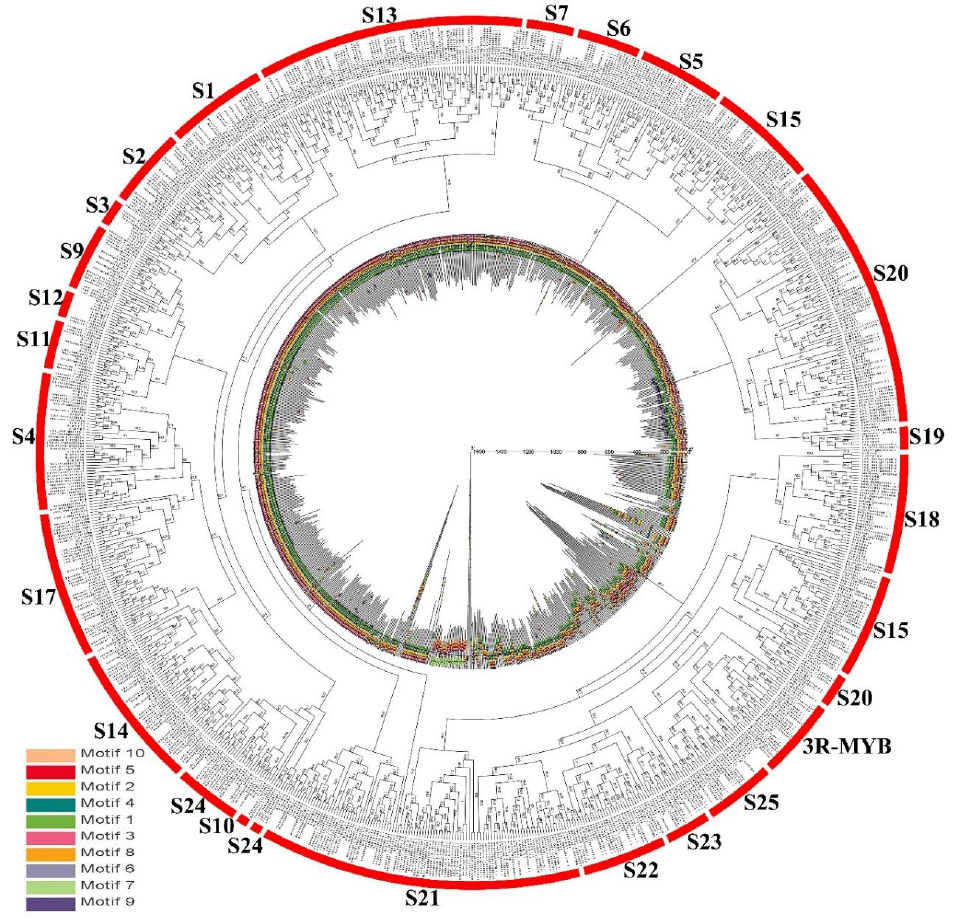
Figure 5. Phylogenetic relationships and motif compositions of the MYB proteins from six different plant species ( Solanum tuberosum L., Arabidopsis thaliana (L.) Heynh., Solanum lycopersicum , Vitis vinifera L., Manihot esculenta Crantz, and Oryza sativa L.). MYB genes from multiple species are classified into S 1, S 2, S 3, S 4, S 5, S 6, S 7, S 9, S 11, S 12, S 13, S 14, S 15, S 17, S 18, S 19, S 20, S 21, S 22, S 23, S 24, and S 25. Outer layer: An unrooted ML phylogenetic tree constructed using Mega 7.0. Inner layer: Distribution of the conserved motifs in MYB proteins. The differently colored boxes represent different motifs and their positions in each MYB protein sequence.